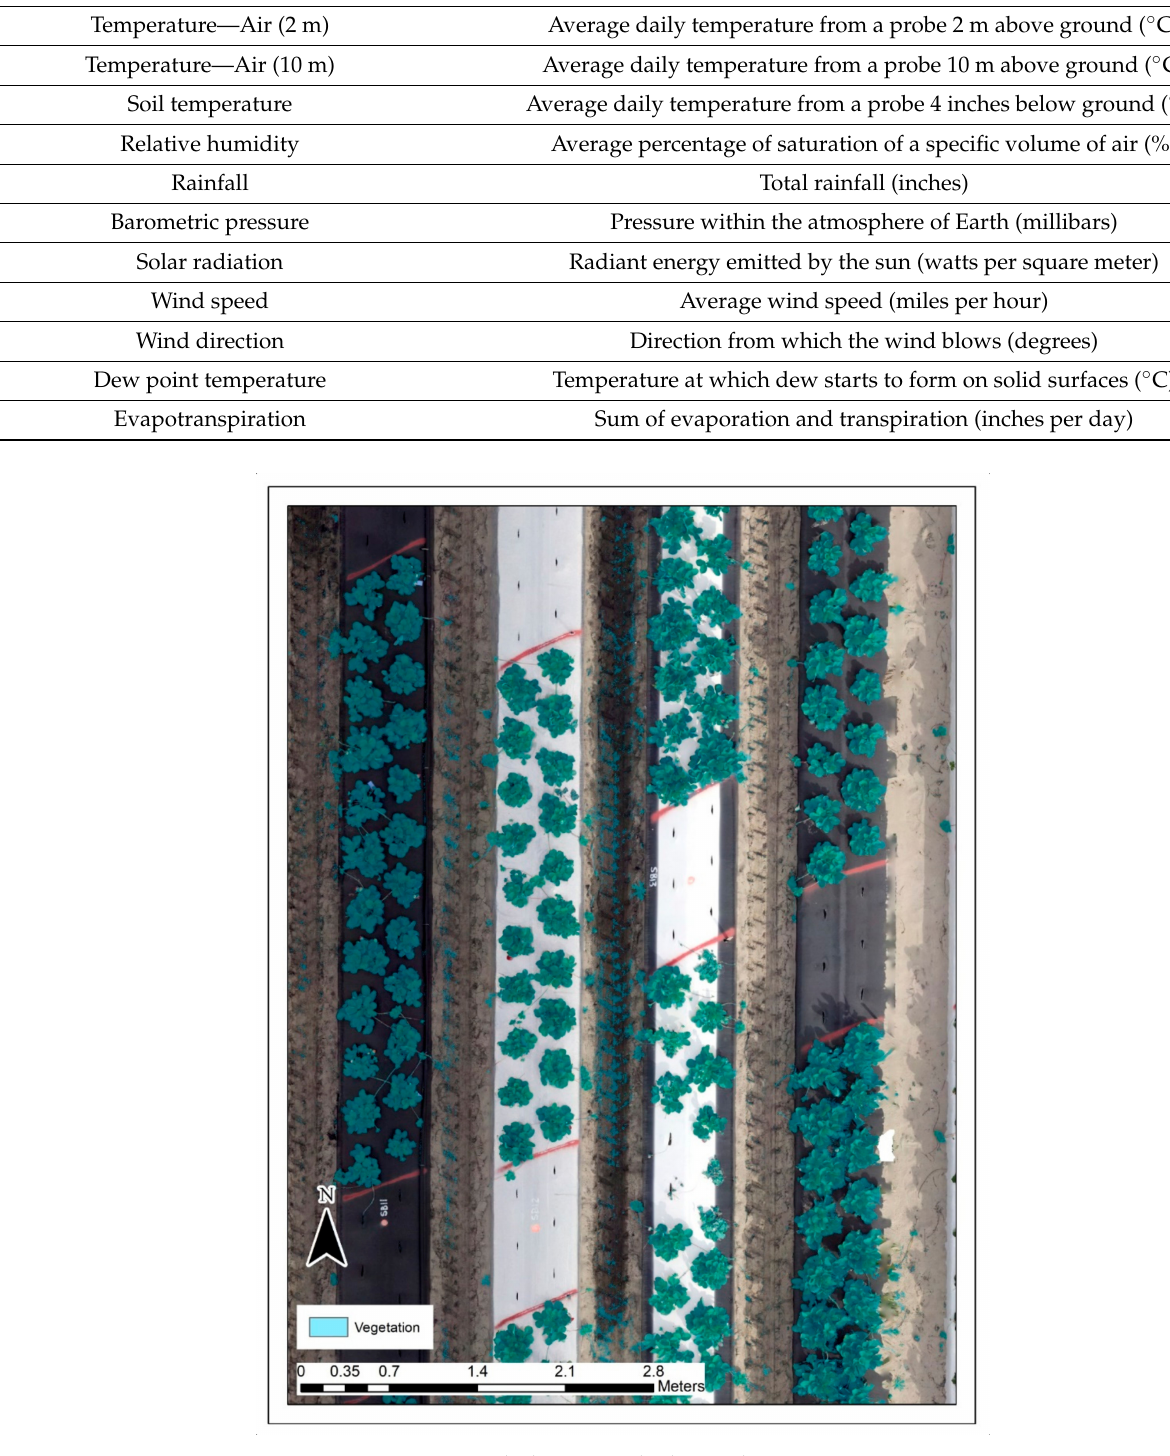
Figure 6. Vegetation mask shown overlaid on